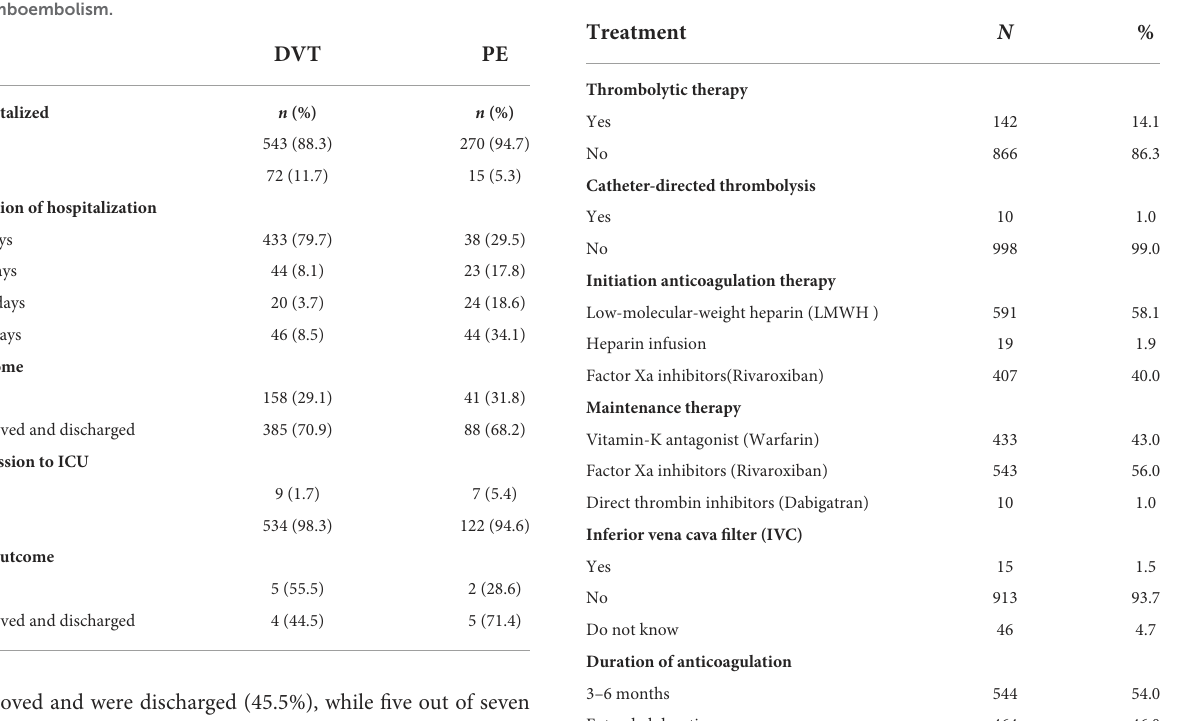
TABLE 4 Treatment of patients with venous